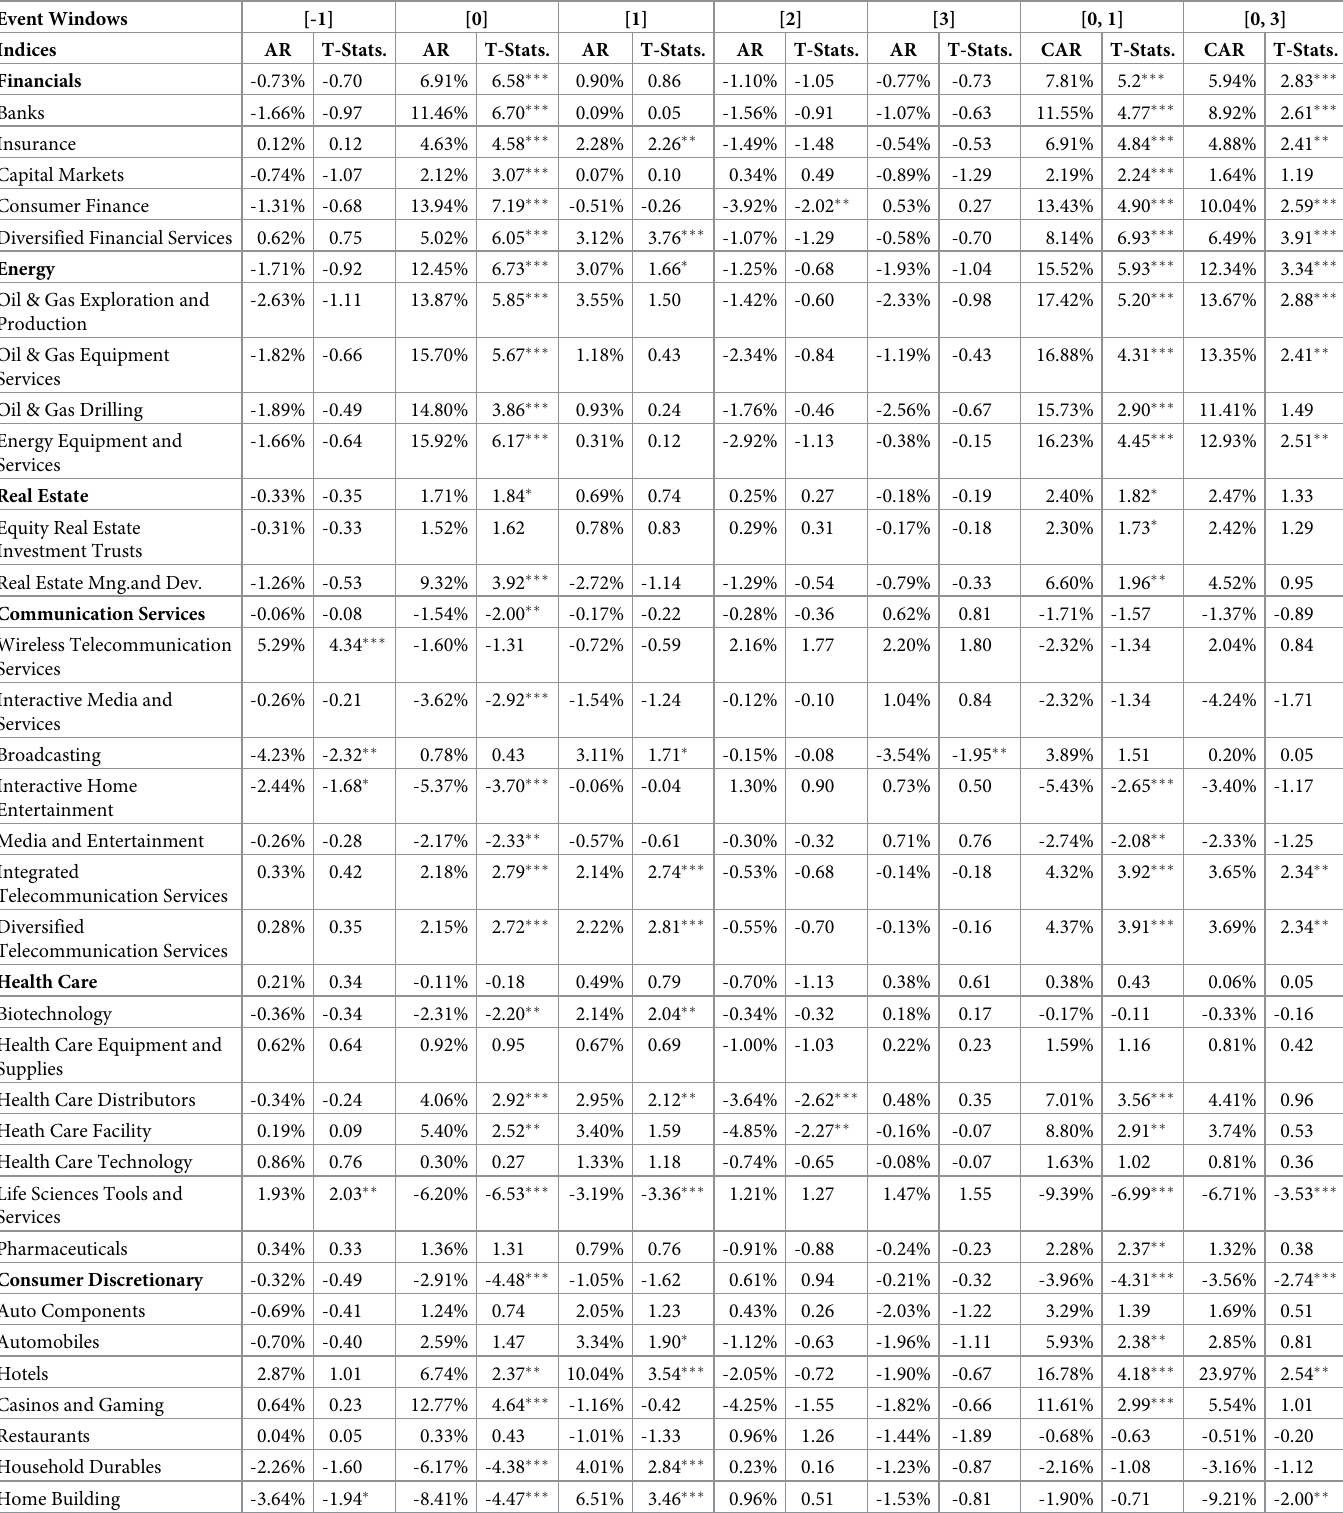
Table 2. Market model abnormal return and cumulative abnormal return for different event windows-estimation period: 23 June 2020–28 October